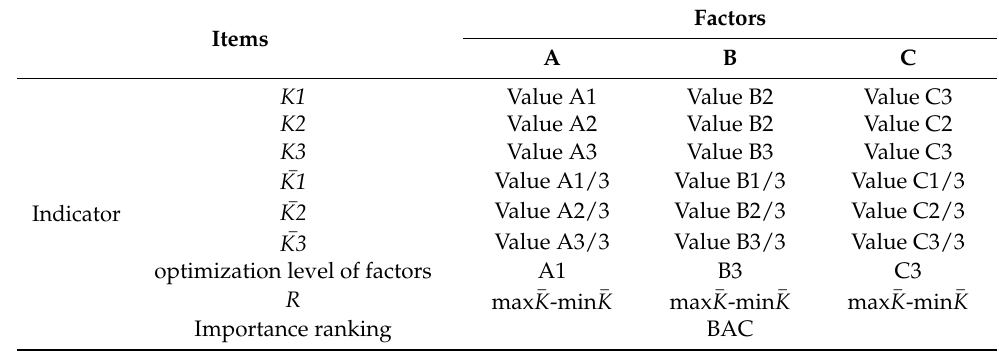
Table 4. Range analysis